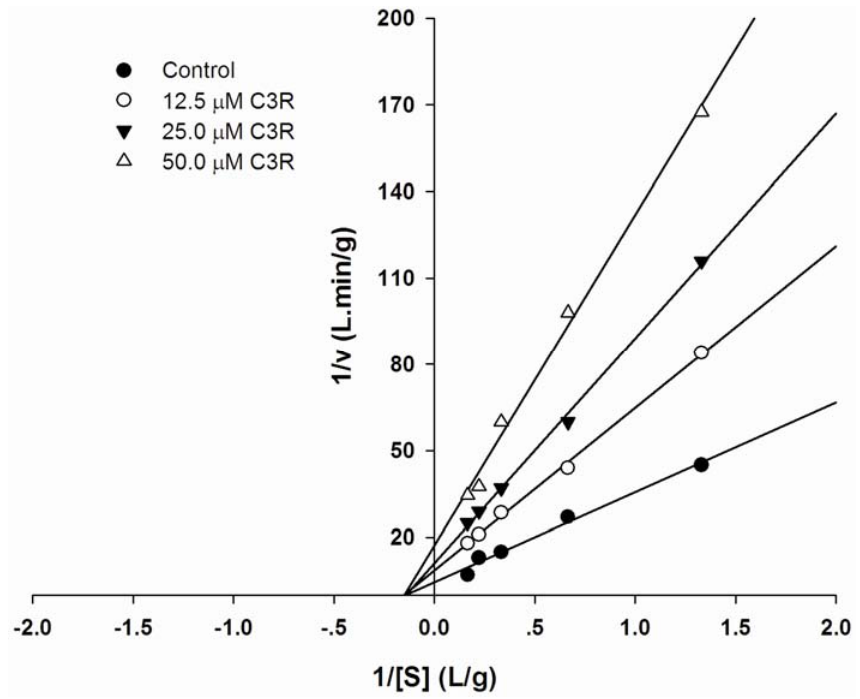
Figure 2. Lineweaver-Burk plots for inhibitory activity of C3R on pancreatic α